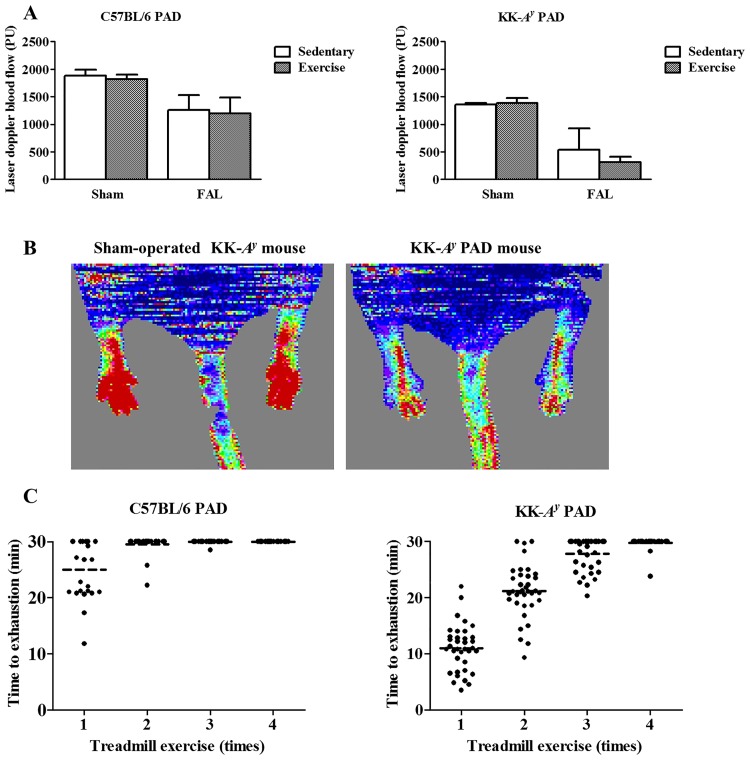
Characterization of the peripheral artery disease (PAD) mouse models.(A) Hindlimb blood flow in sedentary (open bars) and exercised (closed bars) C57BL/6 PAD (left) and KK-Ay PAD (right) mice 3 weeks after femoral artery ligation (FAL). In the exercise groups, mice were subjected to four 30-min treadmill exercise sessions. In the sedentary groups, no mice were subjected to exercise. Two-way ANOVA revealed significant reductions in blood flow after FAL (p < 0.01) in both C57BL/6 PAD and KK-Ay PAD mice. Data are expressed as the mean ± SD, n = 4 for sedentary and exercised sham-operated animals, and n = 8 for sedentary and exercised PAD animals. (B) Representative laser Doppler perfusion imaging 3 weeks after FAL surgery. Left, sham-operated sedentary KK-Ay mice; right, sedentary KK-Ay PAD mice. (C) Time course of recovery of the running performance after FAL surgery in exercised C57BL/6 PAD (left) and KK-Ay PAD (right) mice. Dashes represent the mean time to exhaustion for each session in C57BL/6 PAD mice (n = 24) and KK-Ay PAD mice (n = 30).